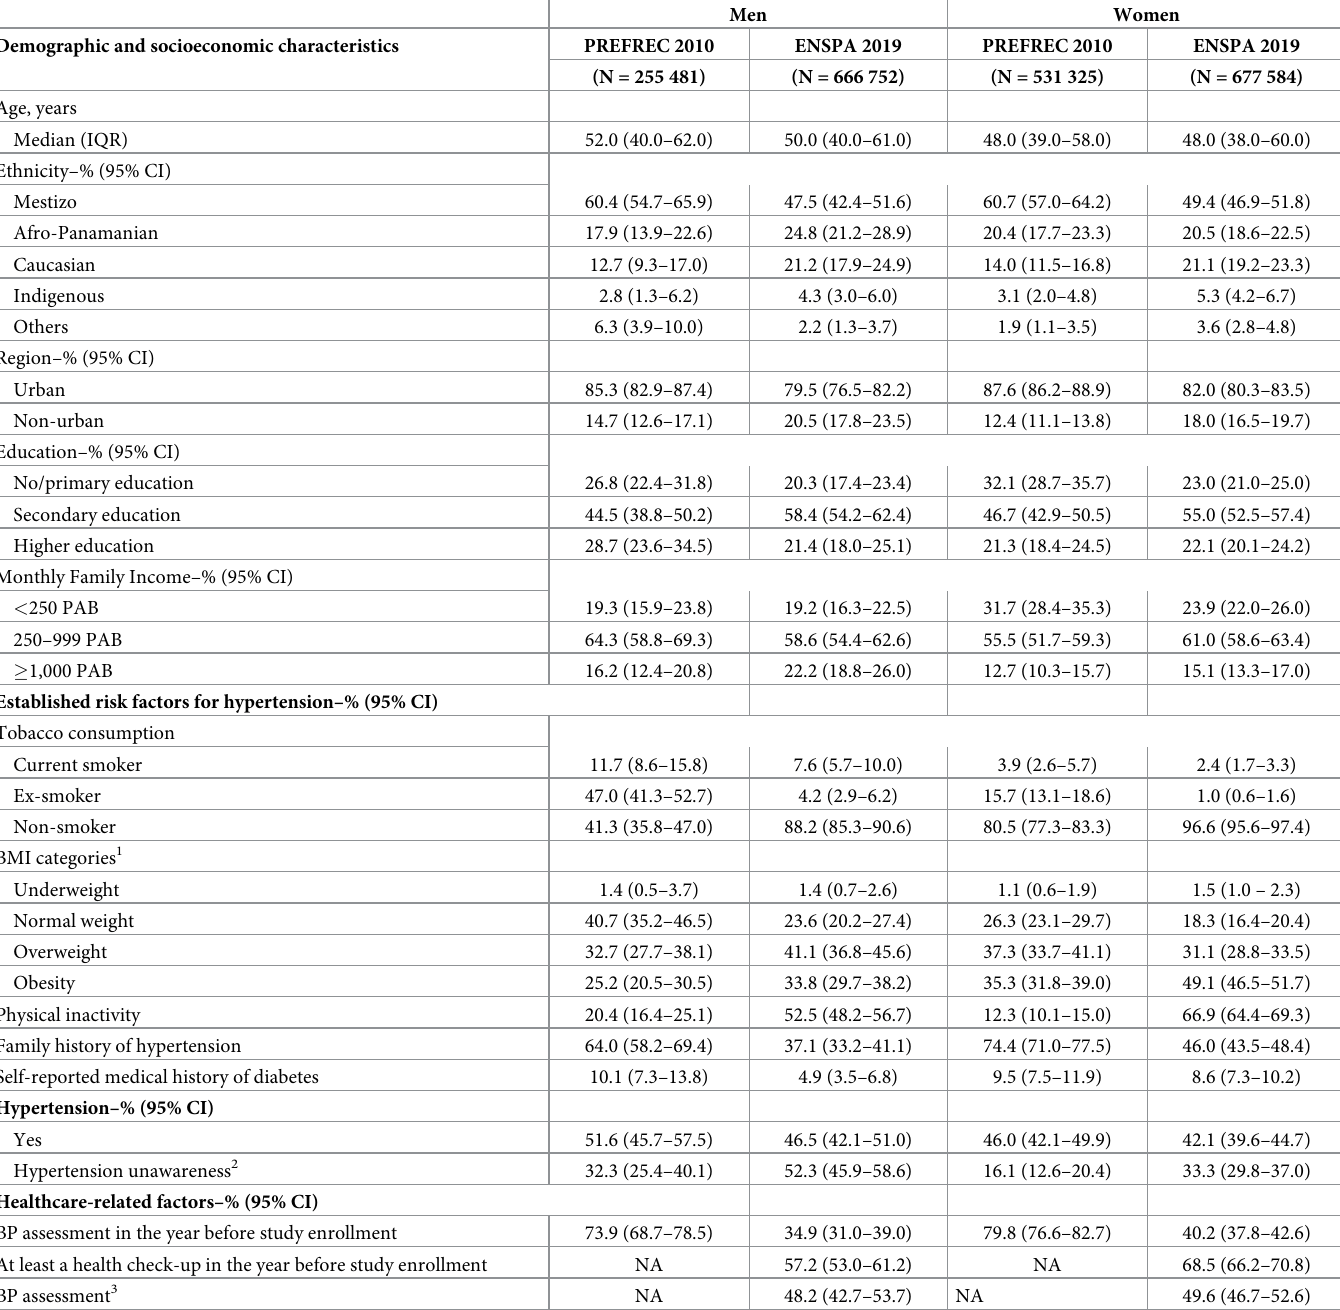
Table 1. Distribution of baseline characteristics in individuals aged between 30 and 75 years by sex and the study year (PREFREC 2010 and ENSPA 2019) in the provinces of Panama and